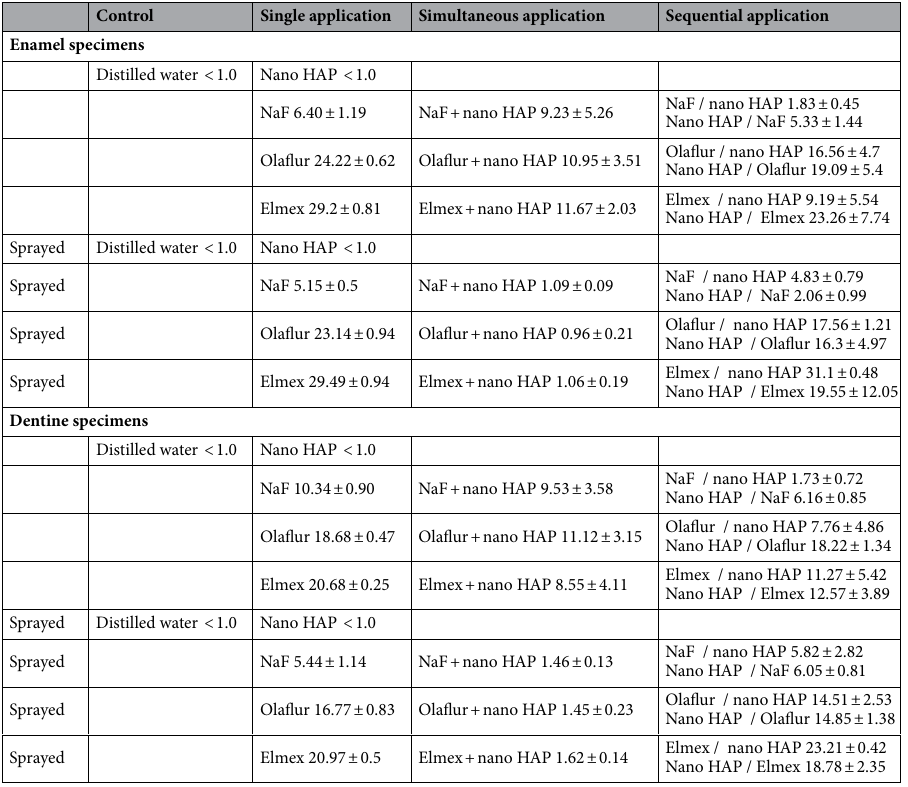
Table 1. Results of EDX analysis of weight percent fluorine (F[Wt%]). Measurements were performed after 5 min incubation in the test solution (distilled water, fluoride, nano-HAP, fluoride + nano-HAP) and after 20 s spraying with the multifunctional syringe (sprayed) according to the different application protocols. Fluoride = sodium fluoride, olaflur and elmex Fluid. Nano-HAP hydroxyapatite